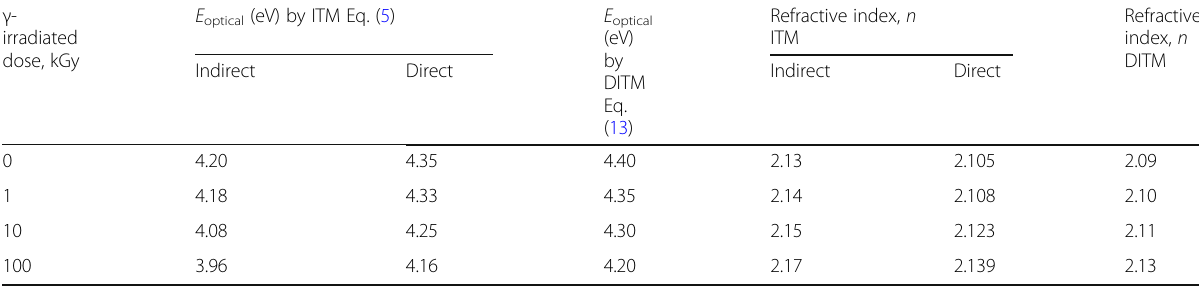
E optical (eV) by ITM Eq. (5)